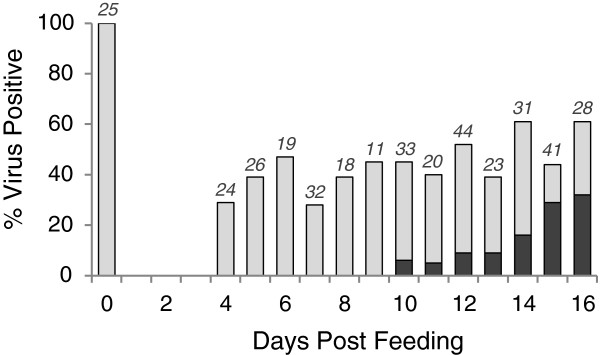
Bar graph showing replication of EHDV-7 over time in C. sonorensis that were infected by feeding on WTD with a high-titer viremia (mean 107.24TCID50/ml). The light bars show percent virus isolation-positive midges (no. positive/no. tested x 100), and the dark bars show the percent of virus isolation-positive midges with a high virus titer (no. of midges with ≥ 102.7 TCID50 per midge/no. of virus isolation-positive midges x 100). Numbers above bars represent the number of blood fed midges processed at each time point